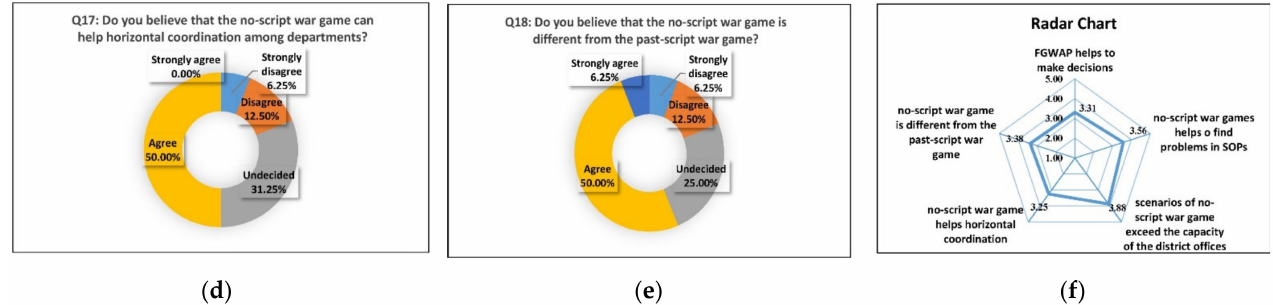
Figure 24. Assessment of the differences between no-script and previously scripted wargames: ( a ) background information, ( b ) prob- lems in SOP, ( c ) capacity exceedance, ( d ) horizontal coordination, ( e ) difference between no-script wargame and script wargame, and ( f ) radar